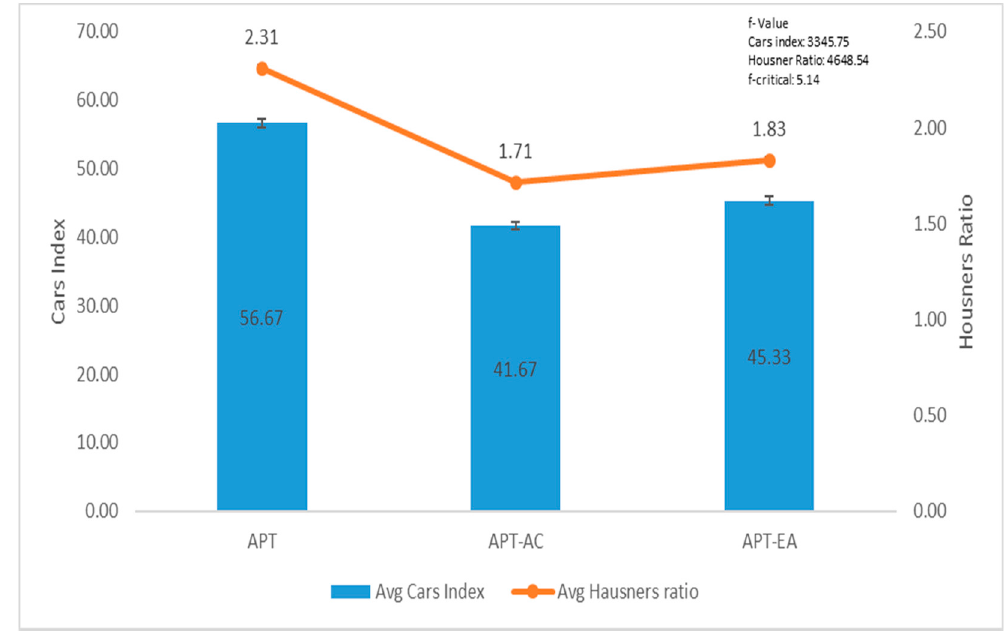
Figure 6. Cars Index and Housner’s ratio. All values were calculated as mean ± SD, n = 3. ANOVA at the p < 0.05 level showed a significant difference.